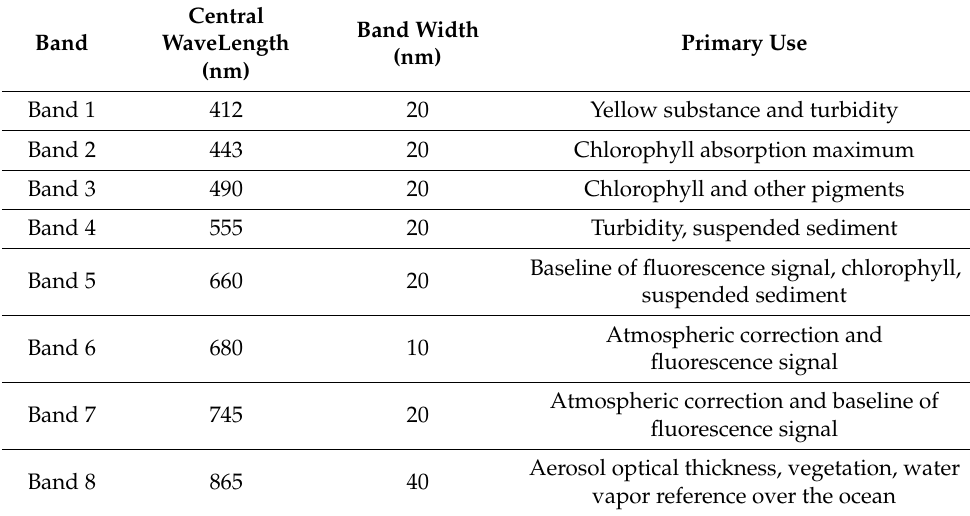
Figure 1. RGB true-color images of study area on 02:16 UTC, 20 September 2016. R, G, and B correspond to GOCI bands 2 (443 nm), 3 (555), and 6 (680 nm), respectively. Table 1. GOCI channel specifications (Ryu et al.